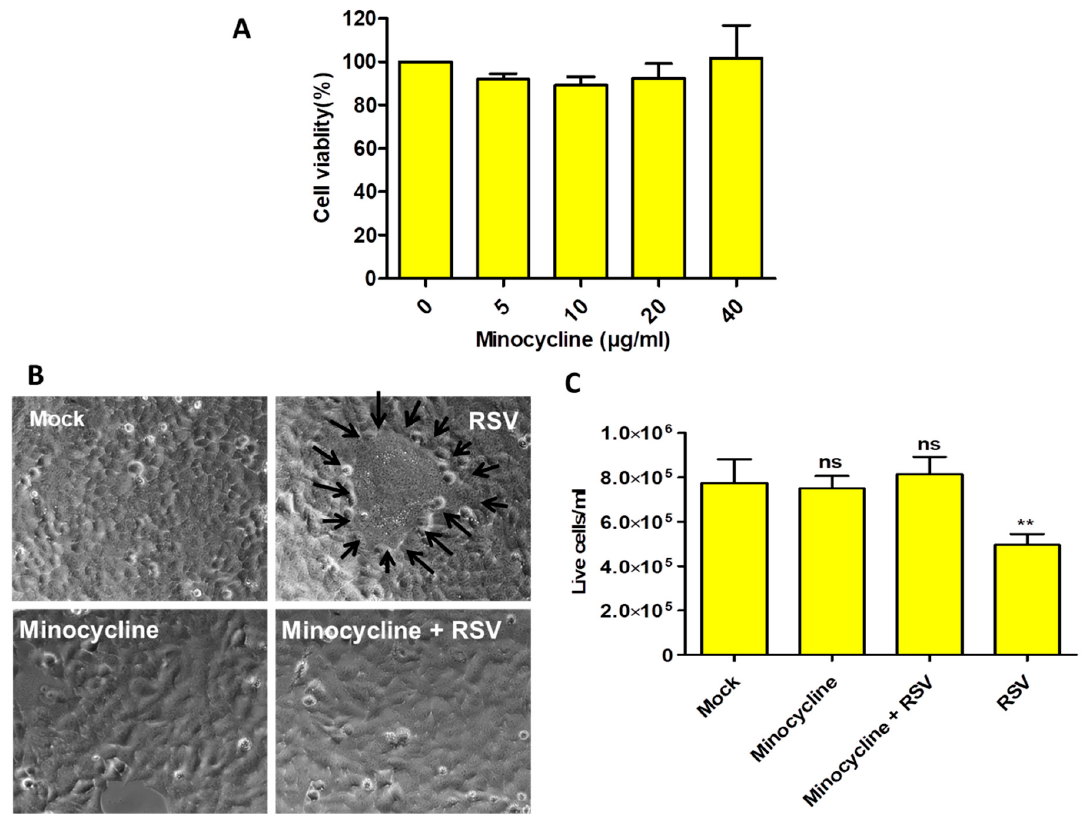
Figure 1. ( A ) The MTT assay showed that minocycline treatment on HEp-2 cells does not cause cytotoxicity. ( B ) Representative images of HEp-2 cells after 48 h of minocycline (10 μ g/mL) or/and RSV, cells treated with minocycline and RSV and RSV infected cells (black arrows surround the syncytia; 400× magnification). ( C ) The corresponding live cell counts for the treatment groups by trypan blue staining. n = 3, values in the graphs represent mean with standard deviation (as error bar) with One-way ANOVA, Tukey’s multiple comparison test, significance level * p ≤ 0.05 or ** p ≤ 0.01 or *** p ≤ 0.0001 or ns as